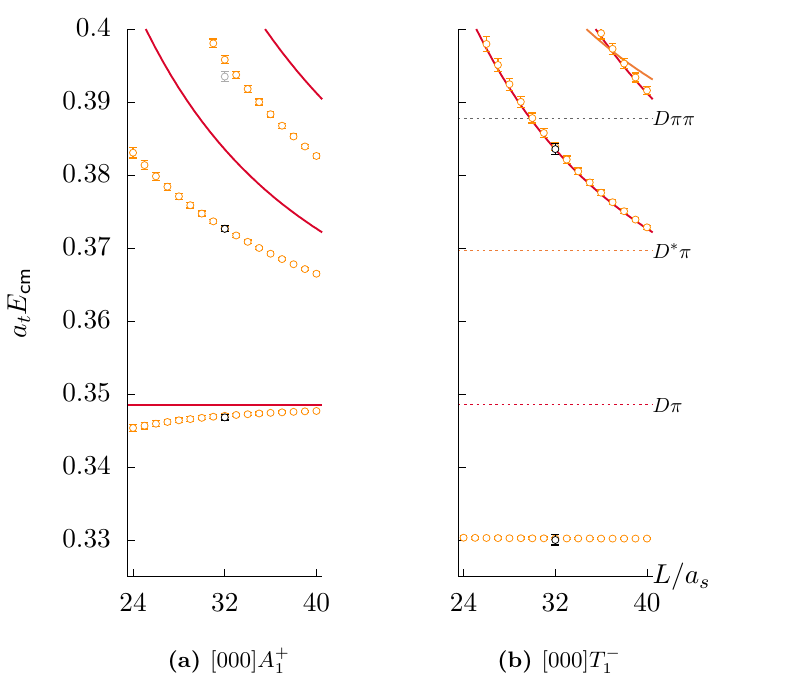
Figure 5. Finite-volume spectra obtained in the at-rest A + with the solutions of the Lüscher determinant condition using the reference parameterisation with the parameters resulting from the χ 2 -minimisation (orange